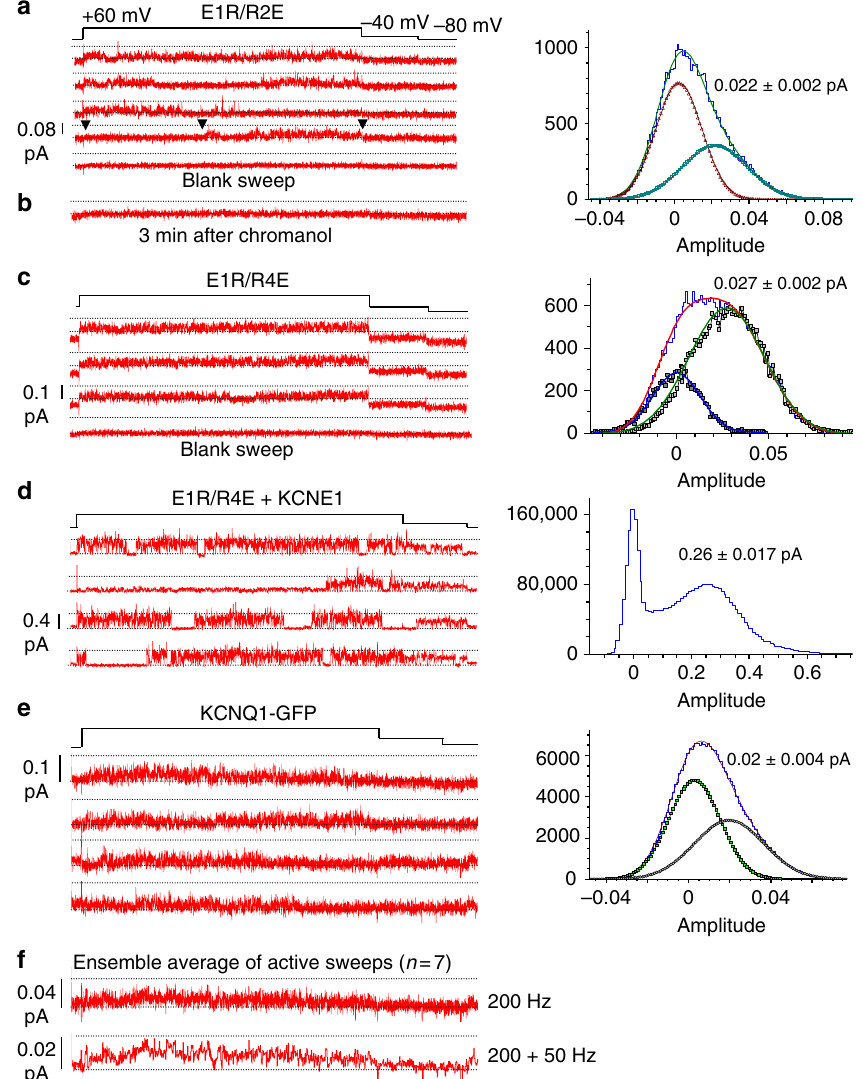
Fig. 6 E1R/R2E, E1R/R4E, and KCNQ1-GFP single-channel recordings. The voltage protocol was the same for all recordings in this fi gure. The potential was stepped from a holding potential of − 80 to +60 mV for 4 s, and then to − 40 mV for 0.75 s, as shown above the current traces. a Representative single- channel current recordings made from membrane patches containing a single E1R/R2E channel. b Addition of 50 μ M Chromanol 293B silenced all E1R/R2E channel activity after ~3 min of exposure. All-points histogram (blue) of the +60 mV portion of the fourth sweep down in a , with closed (maroon) and open (teal) Gaussian fi ts. The peak of the open component is 0.022 ± 0.002 pA. c , d Representative recordings of a single E1R/R4E channel ( c ) or E1R/R4E+ KCNE1 ( d ). All-points histogram (blue) of E1R/R4E of the +60 mV portion of a sweep, showing a signi fi cant closed portion, with closed (blue) and open (green) Gaussian fi ts ( c ) and of 25 active E1R/R4E + KCNE1 sweeps ( d ). e Representative traces of single-channel recordings made from membrane patches containing a single GFP-tagged KCNQ1 channel. All points histogram (blue) of the +60 mV portion of sweeps in e , with closed (green) and open (gray) Gaussian fi ts. The peak of the open component is 0.02 ± 0.004 pA. f Ensemble average of seven active sweeps (of 75 total) of KCNQ1-GFP. The ensemble average was fi ltered again at 50 Hz to show the current waveform more